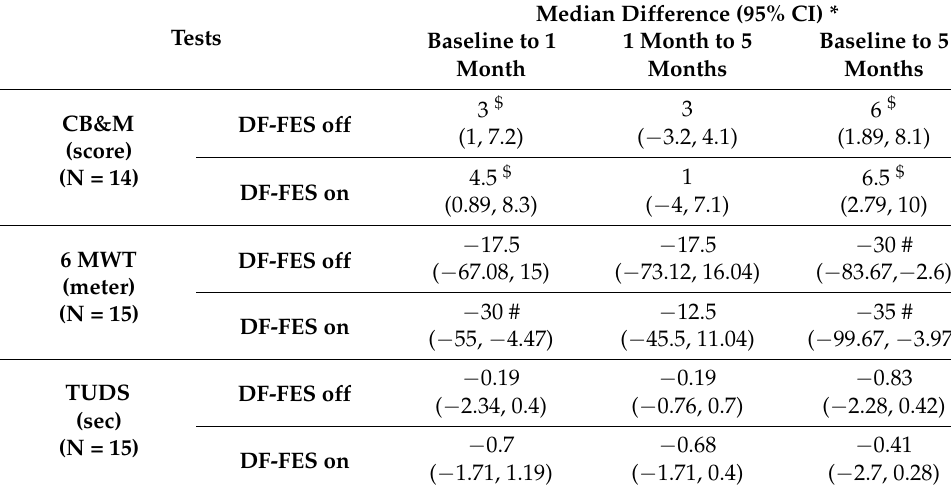
* Main comparisons are between baseline scores (DF-FES off) and one- or five-month scores (DF- FES off and on). CB&M = Community Balance and Mobility Scale; 6MWT = Six-Minute Walk Test;